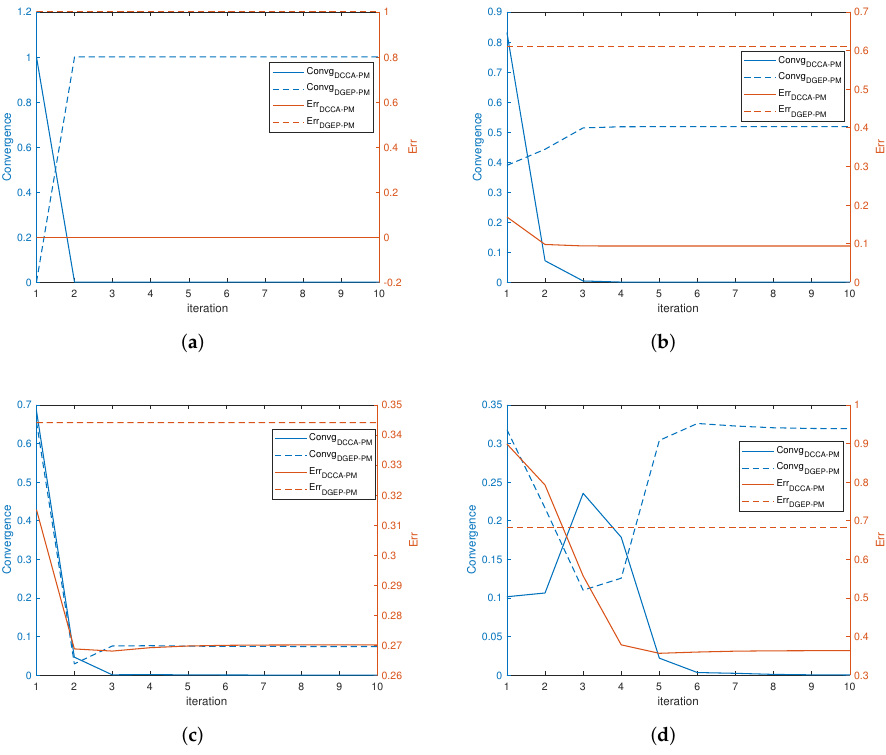
Figure 5. The performance of DGEP-PM and DCCA-PM in distibuted CCA with respect to the number of local servers N . ( a ) N = 1 (centered); ( b ) N = 2; ( c ) N = 4; ( d ) N =